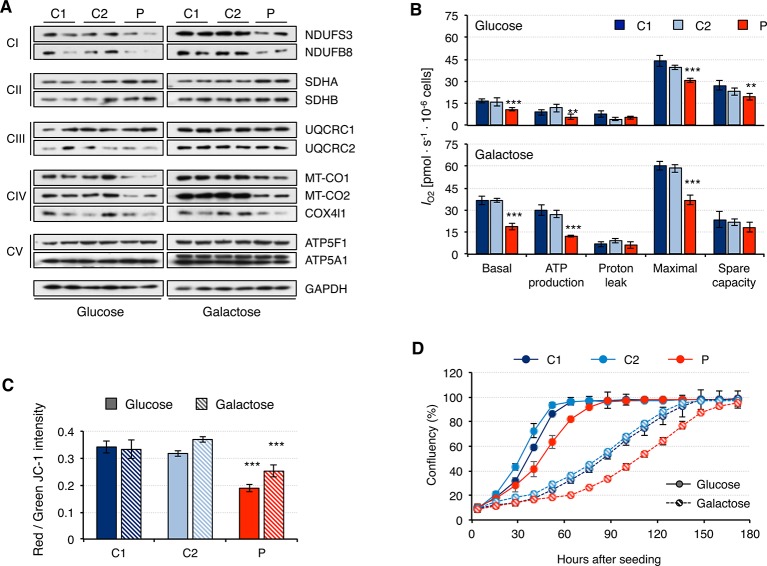
Mitochondrial DNA maintenance in mutant RNASEH1 fibroblasts. (A) Western blot analysis of representative components of the mitochondrial OxPhos complexes I-V in control (C1 and C2) and patient (P) fibroblasts grown in either glucose- or galactose-containing medium. GAPDH was used as loading control. (B) Oxygen consumption (I
O2) measurements in control (C1 and C2) and patient (P) fibroblasts grown in either glucose- or galactose-containing medium. Values of basal and maximal respiration along with ATP production-dependent, proton leak respiration, and spare capacity are presented. Data are shown as mean ± SD, n = 4, Student’s unpaired two-tail t-test, **p < 0.01, ***p < 0.001. (C) Mitochondrial membrane potential in control (C1 and C2) and patient (P) fibroblasts grown in either glucose- or galactose-containing medium using JC-1 staining. Data are shown as mean ± SD, n = 4, Student’s unpaired two-tail t-test, ***p < 0.001. (D) Growth curves of control (C1 and C2) and patient (P) fibroblasts grown in either glucose or galactose. Cell growth was monitored continuously in an Incucyte cell imager (Essen Bioscience). Data correspond to one of the three independent experiments carried out, and they are shown as the mean of three technical replicates ± SD.